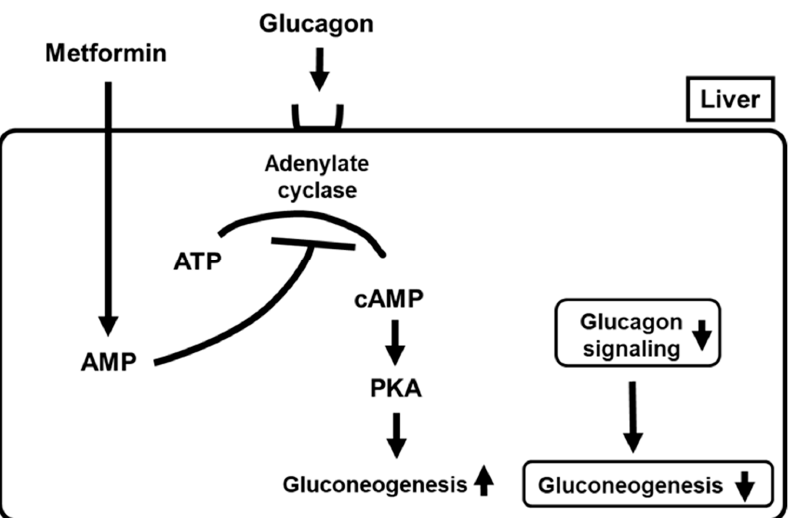
Figure 2. Metformin suppresses glucagon signaling in the liver by suppressing adenylate cyclase which leads to suppression of gluconeogenesis. PKA, protein kinase A. 6. Metformin Reduces Autophagy Failure Observed in Pancreatic β -Cells Under Dia- betic